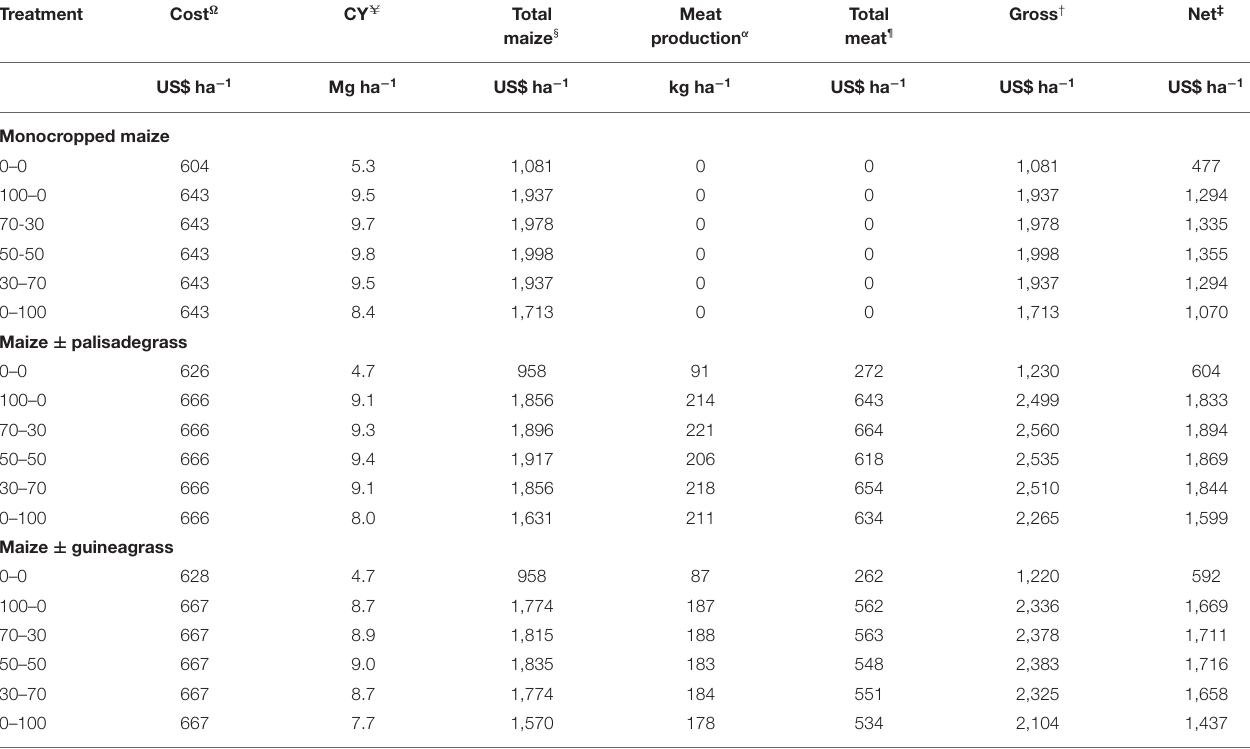
TABLE 5 | Economic evaluation of monocropped maize, maize intercropped with palisadegrass and maize intercropped with guineagrass as a function of N management for maize (average of three growing seasons). Treatment Cost (cid:127) Meat